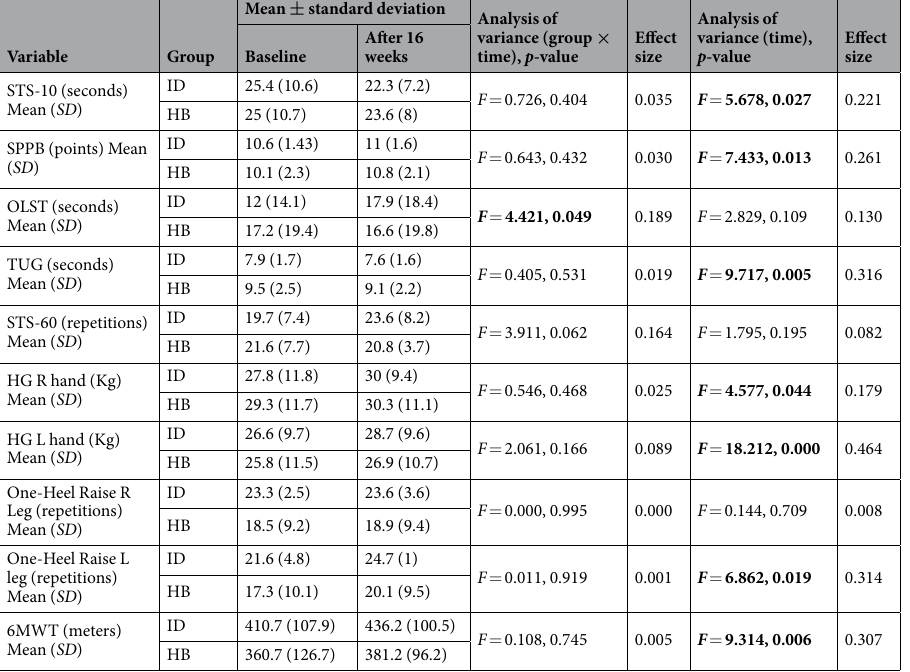
Table 3. Mixed model of repeated measures for the physical functioning tests. STS: the sit-to-stand test; SPPB: Short Physical Performance Battery; OLST: One-leg standing test; TUG: timed up-and-go test; HG: handgrip strength; 6MWT: 6 minutes walking test. Baseline data comparison between ID (n = 11) and HB (n = 12) with the Mann-Whitney test showed no significant